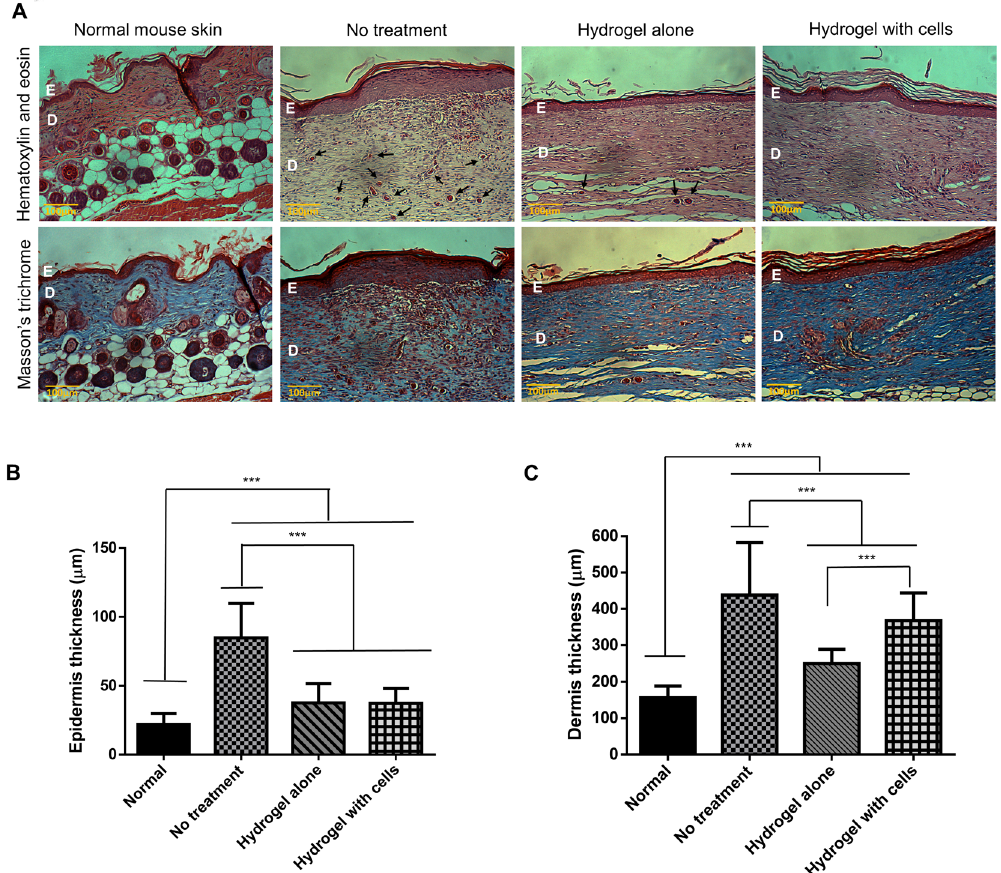
Figure 5. Histological analysis of the skin at day 13 post-treatment or no treatment. ( A ) H&E and Masson’s trichrome staining under 100 × magnification. E refers to the epidermis layer; D refers to the dermis layer; arrow ( ) refers to blood vessel ( B ) Thickness of the epidermis layer and ( C ) Thickness of the dermis layer of normal mouse skin compared to the different treatment groups. The asterisk ( *** ) represents a significant difference (p < 0.001) between